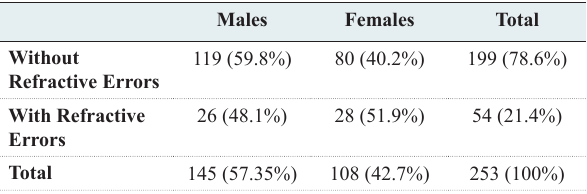
Table 1: Prevalence of refractive errors according to gender Table 3: Different types of refractive errors according to gender